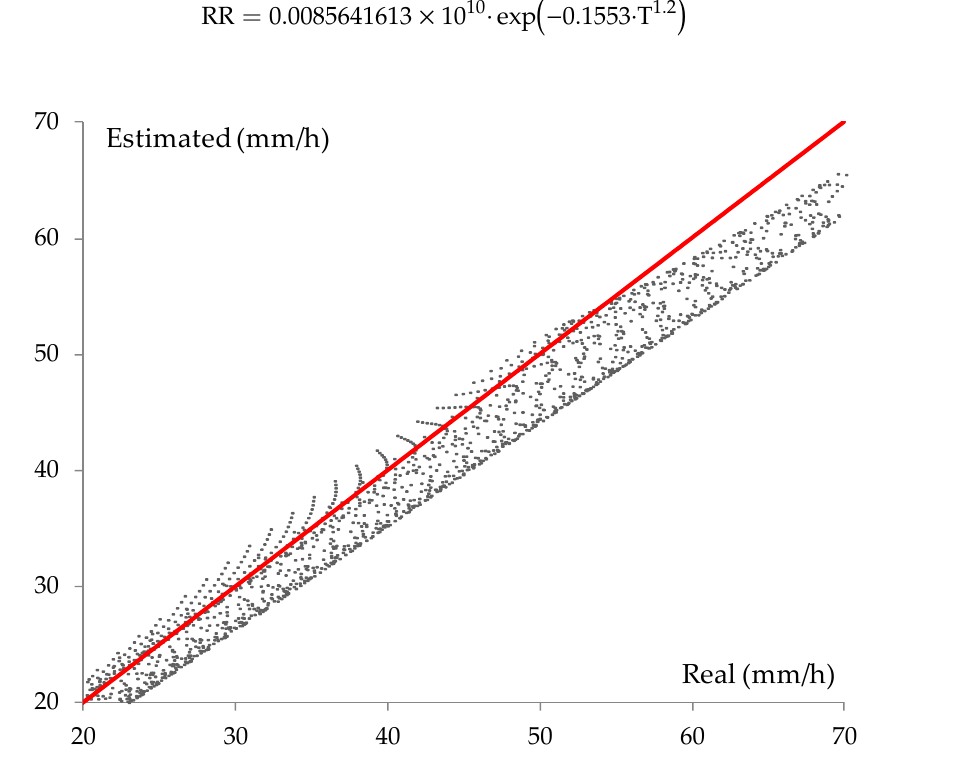
Figure 5. Validation of the methodology using data from Hurricane Odile, 14 (23:50) to 15 (02:10) September 2014 at MGS Cabo San Lucas, BCS. (R 2 = 0.9387).